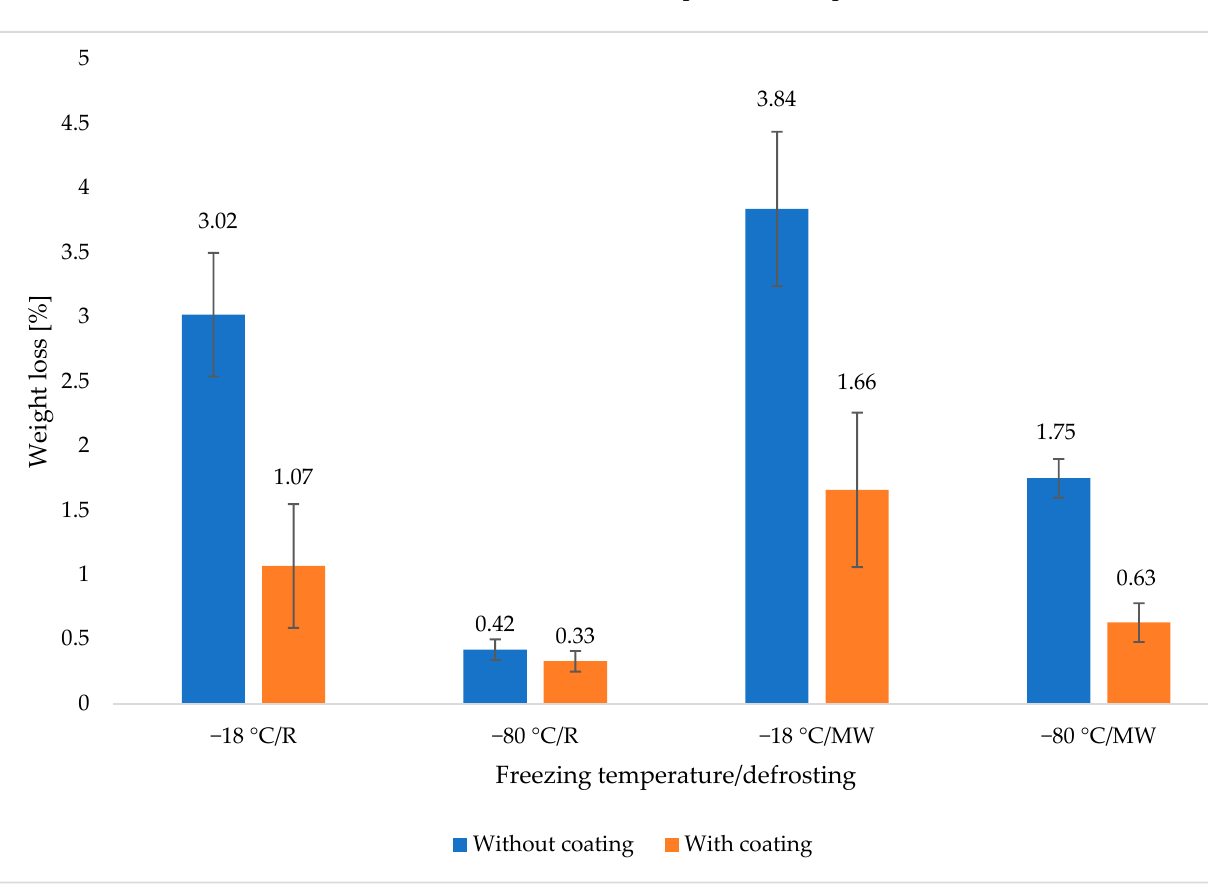
Figure 1. Weight loss of meat without coating and with crosslinked coating depending on the method of freezing and thawing.